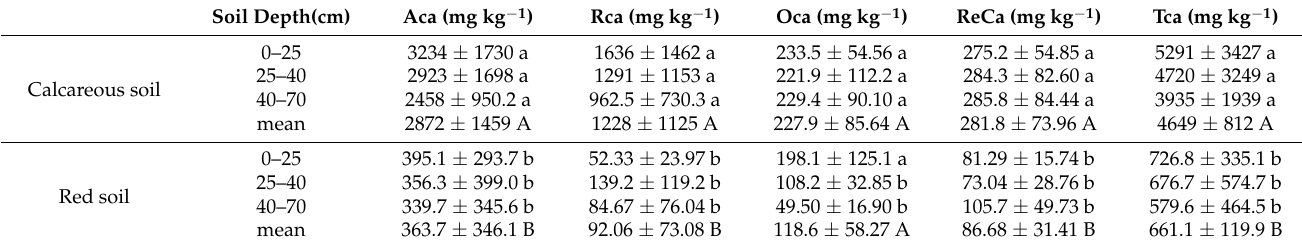
Table 2. Acid soluble (Aca), reducible (Rca), oxidable (Oca), residual (ReCa), and total (Tca) fractions of the calcium content in calcareous soil and red soil